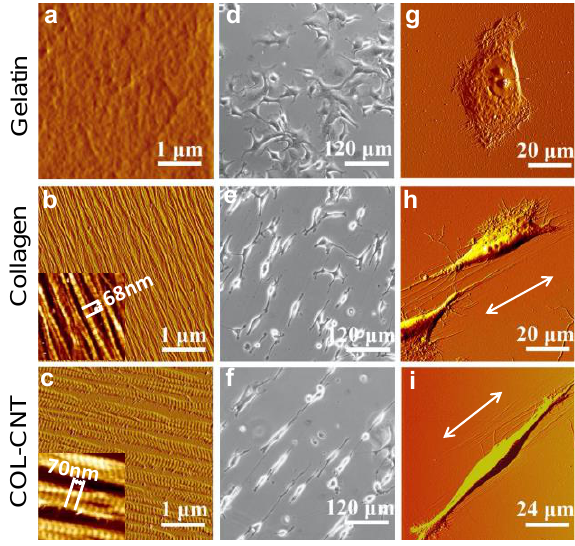
Figure 1. Characterization of the selected matrices and the cell growth. ( a – c ) AFM images (in amplitude mode) of gelatin ( a ), collagen ( b ) and COL-CNT matrices ( c ). The insets (1.6 × 1.6 µm 2 ) highlight the distinctive D-period for collagen and COL-CNT fibrils. ( d – f ) Phase images of SKOV3 cells 24 h post-plating on the matrices. ( g – i ) AFM images (in amplitude mode) illustrating individual SKOV3 cells on the matrices. The arrows indicate the direction of fibril alignment.